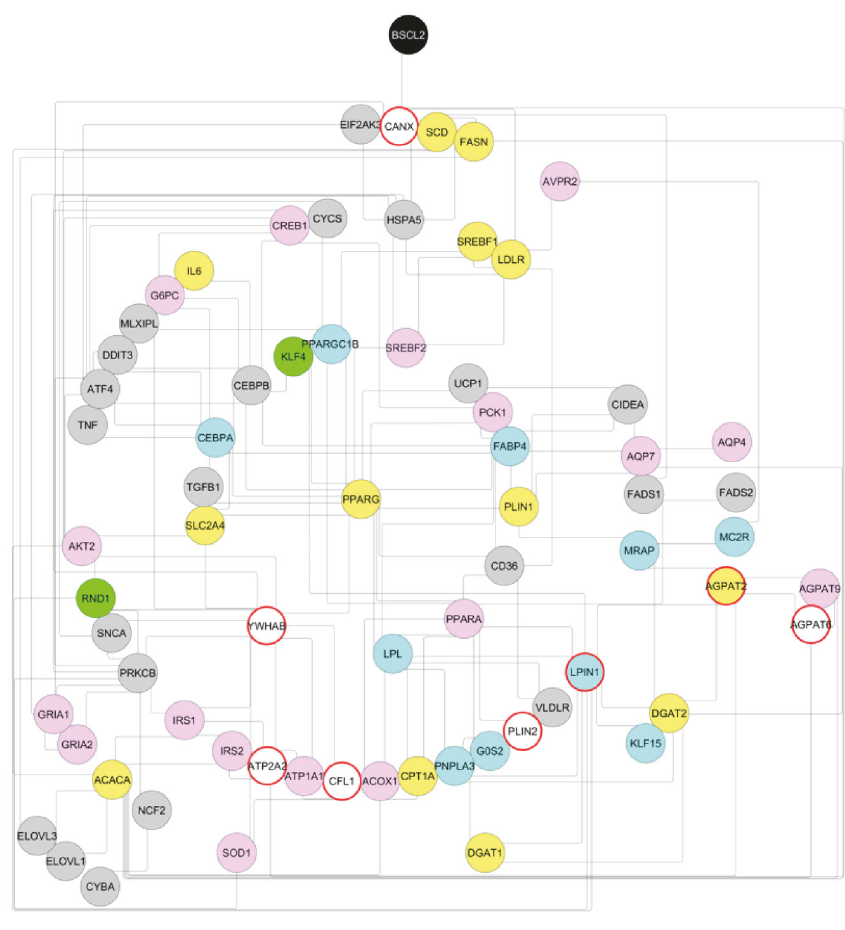
Figure 8: Biological integration . A network with genes differently regulated in seipin loss-of-function situations was created using STRING [41]. The gene list submitted is in accordancewith Supplementary Tables 1 and 2. Genes painted with green are upregulated in adipogenic cells with seipin loss-of-function. Genes painted with blue are downregulated in adipogenic cells with seipin loss-of-function. Genes painted in gray are upregulated in nonadipogenic cells with seipin loss-of-function and genes painted in pink are downregulated in nonadipogenic cells with seipin loss-of-function. Genes that were observed either downregulated or upregulated in the same cell situations but in different papers are painted in yellow (mixed expression). Proteins already described as seipin physical binders are surrounded by a red circumference. The parameters chosen were “Experiments,” “Databases,” “Coexpression,” “Neighborhood,” “Gene Fusion,” “Cooccurrence,” and “Minimum required interaction score = 0.1.” Cytoscape [42] classifies the genes based on their connectivity. As the circle comes to the center, the node tends to be more connected with the